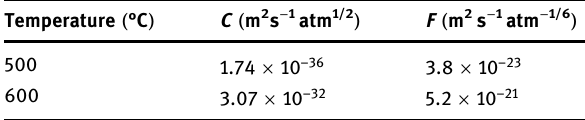
Table 5: The results of extrapolation of parameter C and parameter